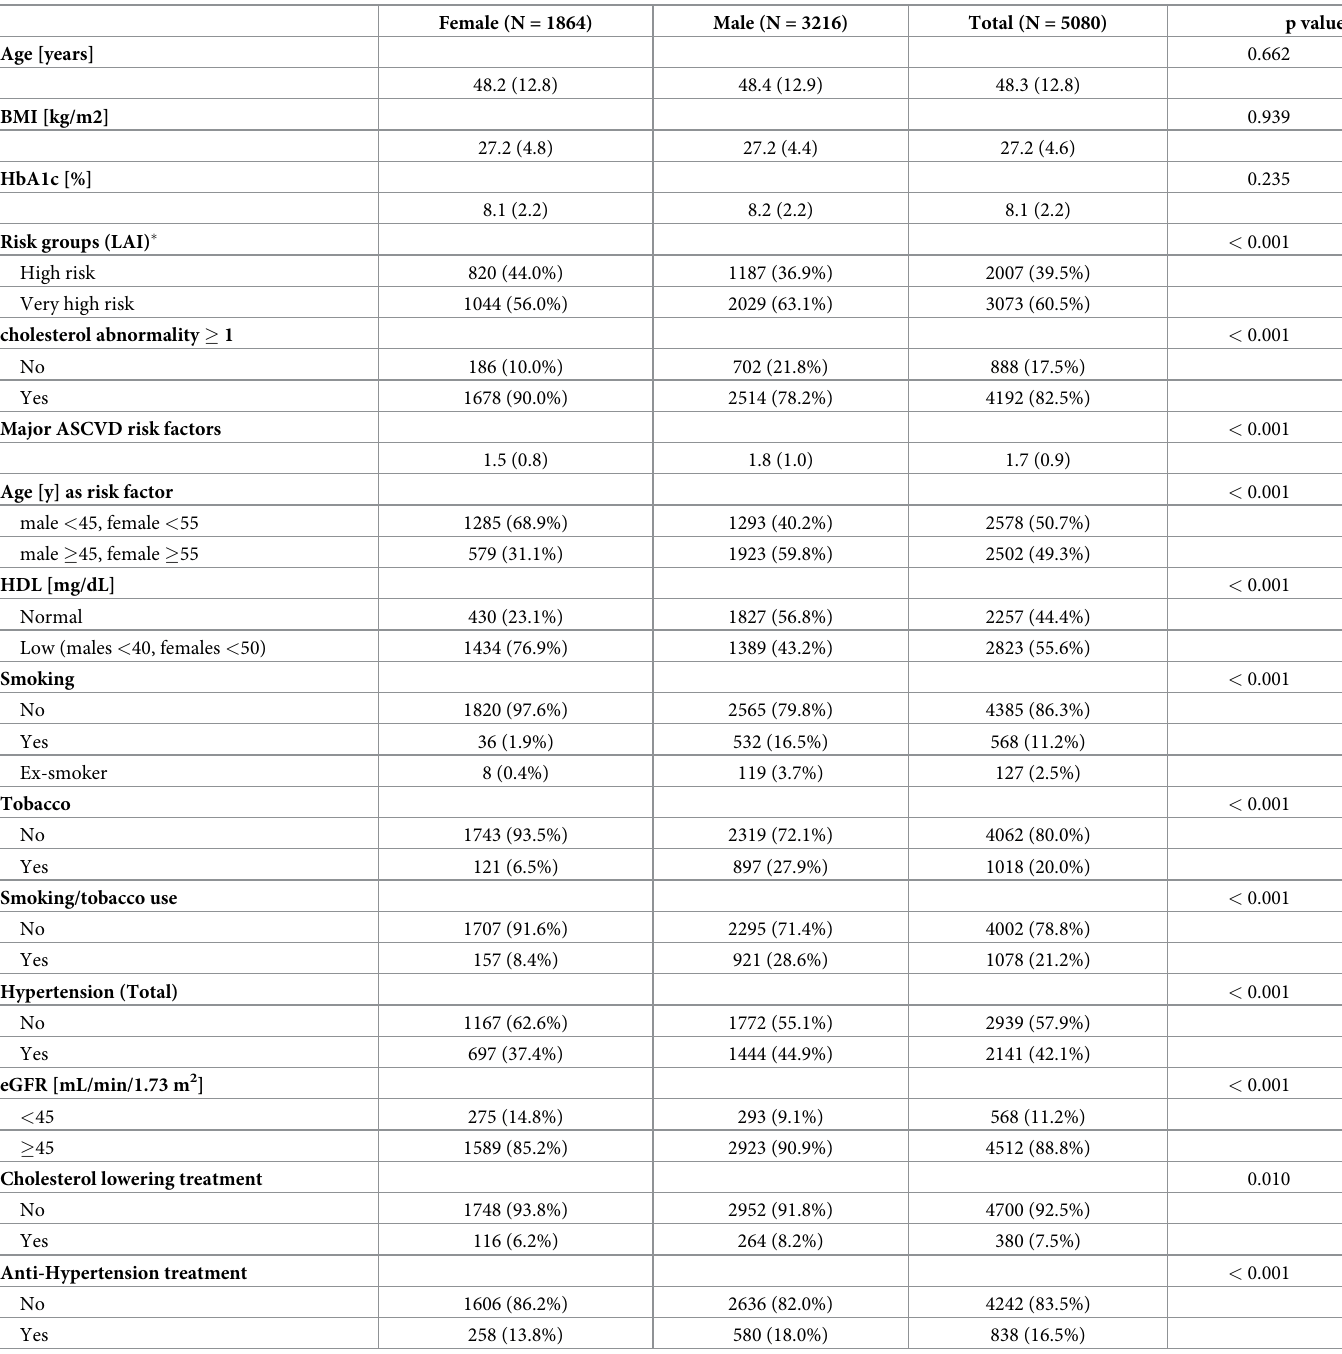
Table 1. Atherosclerotic risk factors separated according to sex, qualitative